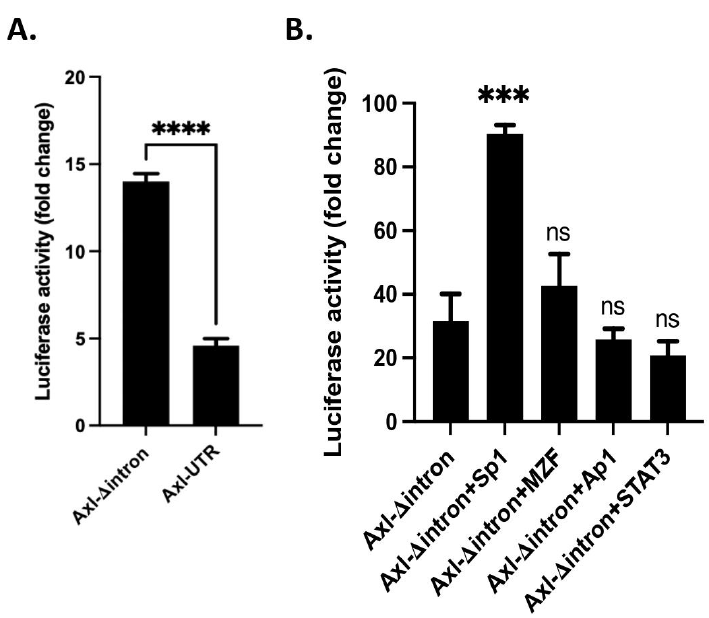
Figure 3. Inhibitory role of mini-intron in Axl promoter region. Hela cells were transfected with the Axl- Δ intron constructs alone ( A ) or together with the transcription factor vectors ( B ) as described in the methods. Experiments were repeated three times. Luciferase activity was analyzed, and re- sults were presented as mean ± SD. Student t -test was performed to compare with the luciferase activity from Hela cells transfected with the Axl- Δ intron construct. *** p < 0.001, **** p < 0.0001, ns, not significant.